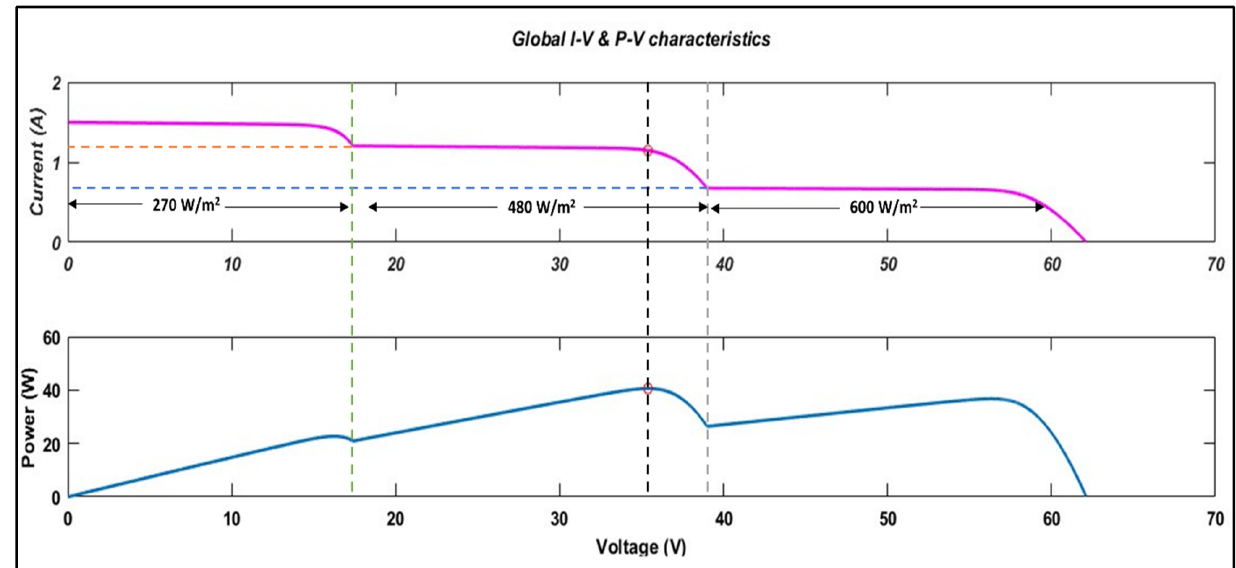
Figure 10. Shading-based simulation model of 40-Watt solar panel with bypass diode.